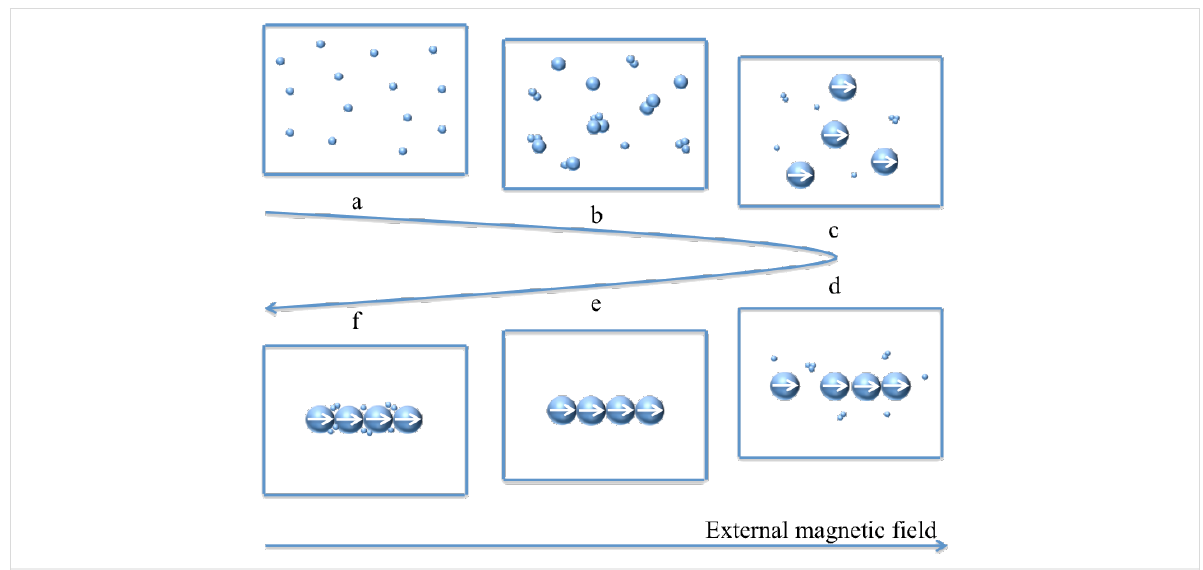
Figure 5: Schematic diagram of the stepwise formation of Ni